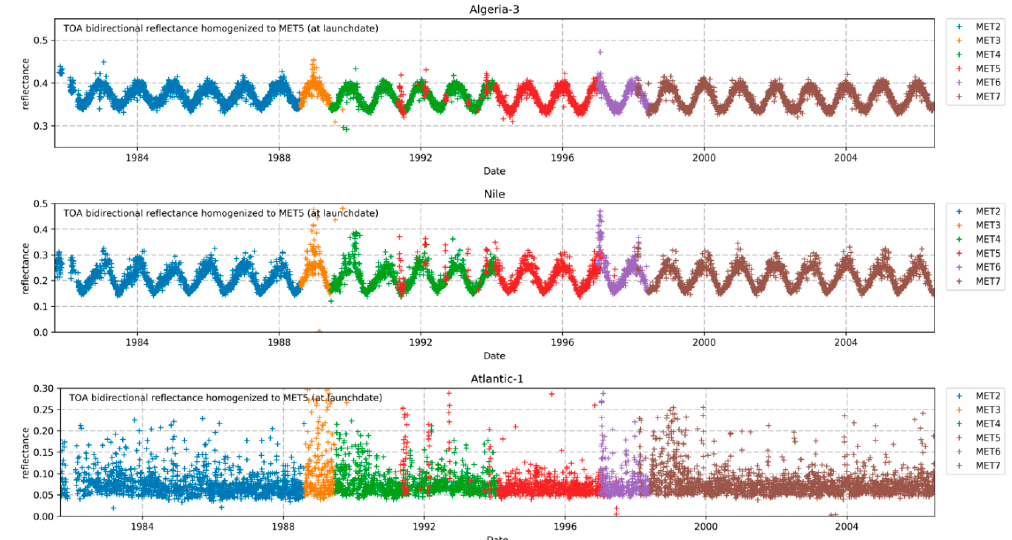
Figure 11. Homogenised time series of recalibrated broadband reflectances at Algeria-3, Nile-delta and Atlantic-1.